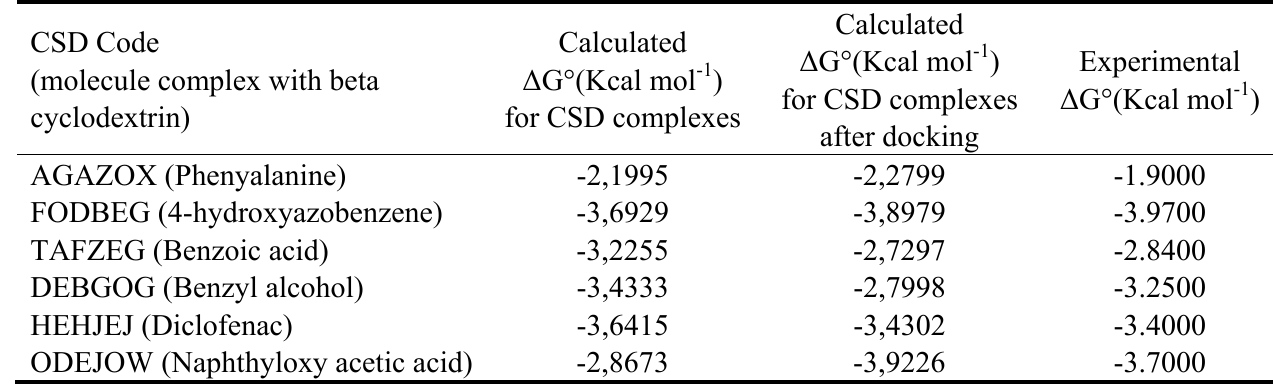
Table 1. Calculated Δ G° for CSD complexes , Δ G° for CSD complexes after redocking and Δ G° experimental.